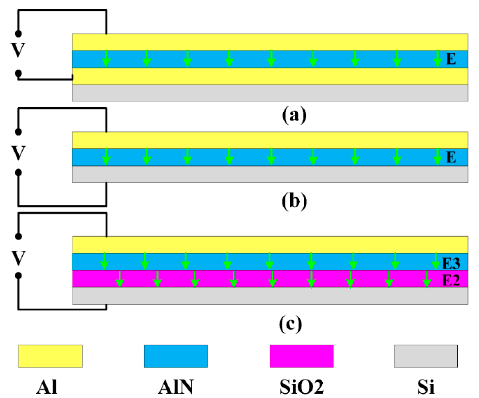
Figure 3. The simplified schematics of configurations of the applied voltage when the second layer is electrode, null, and SiO2. ( a ) The second layer is electrode, the top and bottom electrode are connected with the voltage and ground; ( b ) the second layer is null, that is there are only three layers: top electrode, piezoelectric layer, and substrate. The top electrode and the substrate are connected with voltage and ground; ( c ) the second layer is SiO2, the top electrode and the sub ‐ strate are connected with voltage and ground. In most cases, the piezoelectric cantilever consists of top electrode, piezoelectric layer, bottom electrode, and the substrate. The top electrode and bottom electrode are connected with voltage and ground, respectively, making the cantilever bent, which has been ana ‐ lyzed and discussed above. In some applications where large displacement is desired, the bottom electrode does not need to be designed and fabricated, so that the second layer is